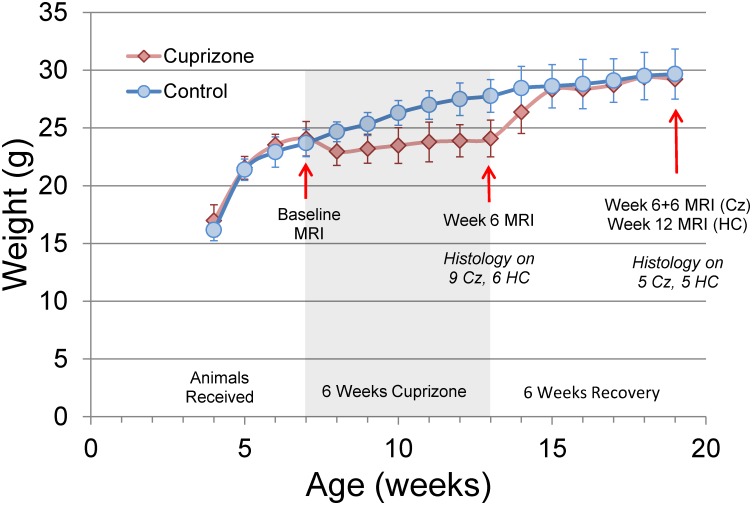
Weight Gain and Study Design.Average weight of animals over the course of the study (error bars represent one standard deviation). Cuprizone diet was administered for 6 weeks (shaded area) beginning 3 weeks after delivery. After one week on cuprizone the treatment group (Cz) exhibited lower weight than healthy controls (HC; *p<0.005); weight gain increased one week after cuprizone was removed from the diet, and two weeks into recovery no difference can be seen between the two groups’ weights.